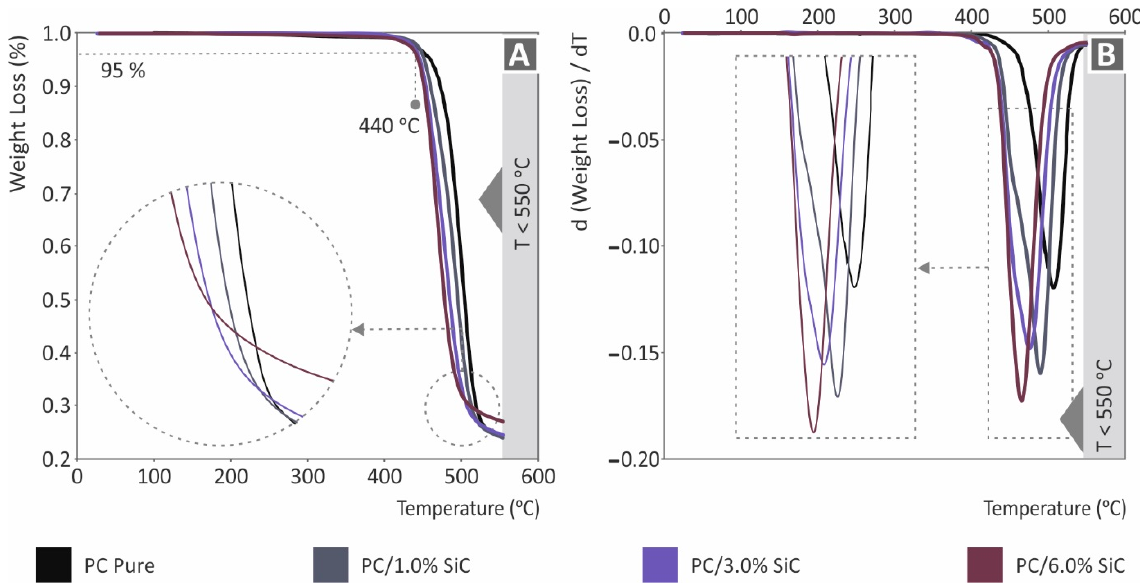
Figure 2. Pure PC and PC/SiC nanocomposites TGA results: ( A ) graph of the weight loss (%) compared to temperature ( ◦ C); ( B ) graph for the mass degradation rate (dw/dT) compared to temperature ( ◦